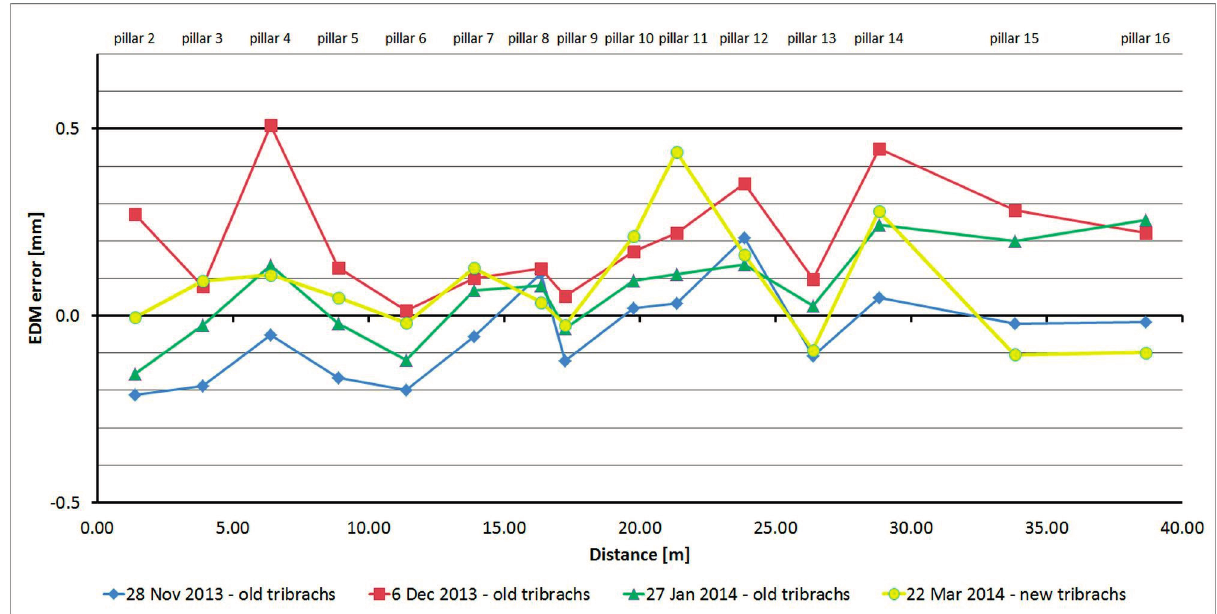
Figure 10. Leica TC1202–Absolute errors in four